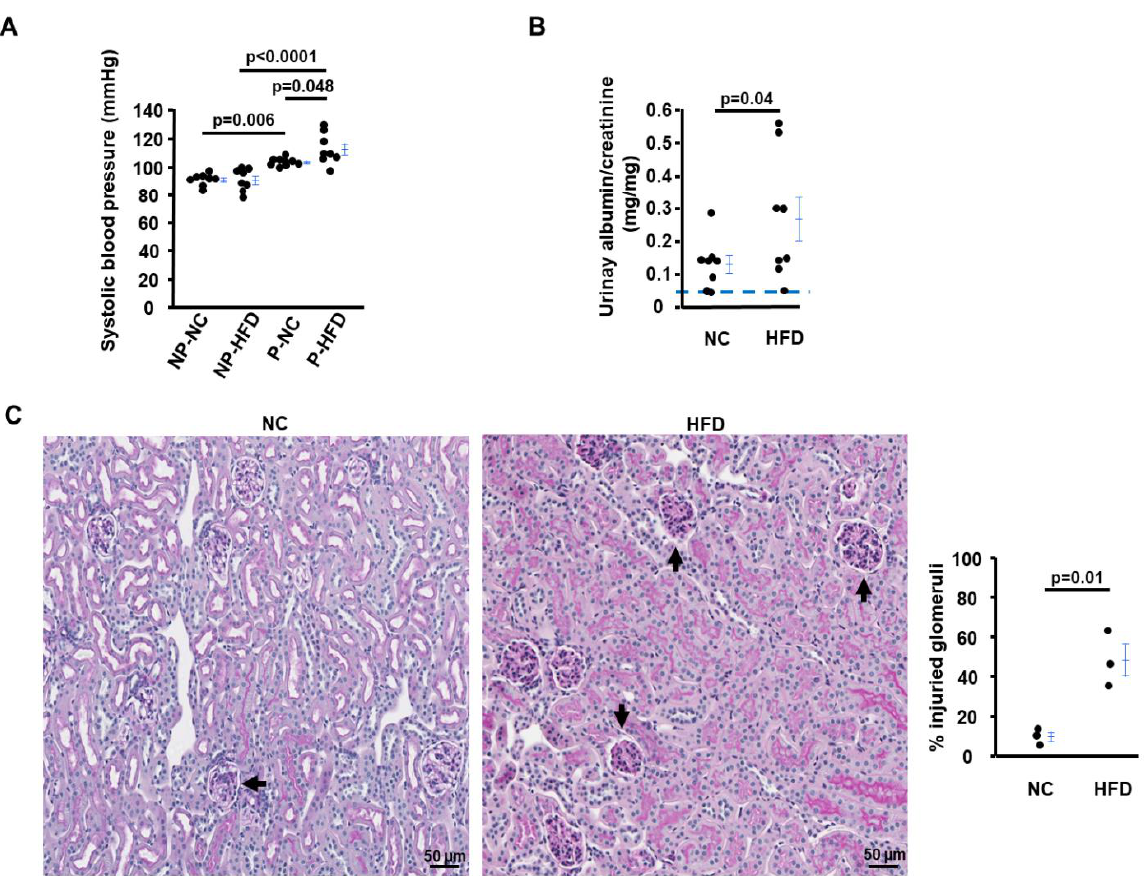
Figure 3. Asb4 −/− pregnant mice fed a high-fat diet (HFD) have higher blood pressure and urinary protein and more kidney damage than Asb4 −/− pregnant mice fed normal chow (NC). ( A ) Systolic blood pressure (SBP) in Asb4 −/− female mice (non-pregnant and pregnant) after approximately 7 weeks of HFD or NC feeding regimen. NP-NC: non-pregnant with NC; NP-HFD: non-pregnant with HFD; P-NC: pregnant mice with NC; P-HFD: pregnant mice with HFD. ( B ) Urinary albu- min/creatinine ratio in Asb4 −/− dams at 18.5 days post-coitus (dpc). The blue dashed line indicates the normal value. n ≥ 8. ( C ) Representative glomeruli from two different diet groups. Periodic acid – Schiff stain. Right panel: semi-quantitation of the percentage of injured glomeruli; n = 3. Black arrow: injured glomeruli.